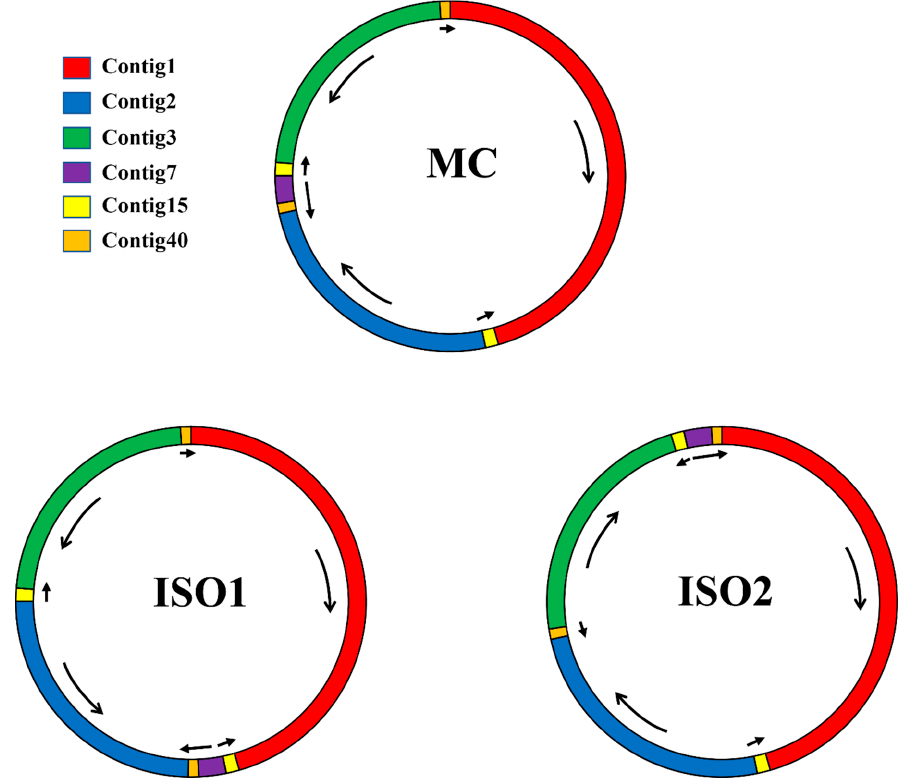
Figure 1. The master genome and two isomeric genomes observed from P. vulgaris mitogenome mediated by two pairs of large repeats (Contig15 and Contig40). The mt contigs were generated and selected from Newbler assembly software. MC and ISO mean the master and isomeric conformations, respectively. Arrows denote the sequence orientation of assembled contigs.